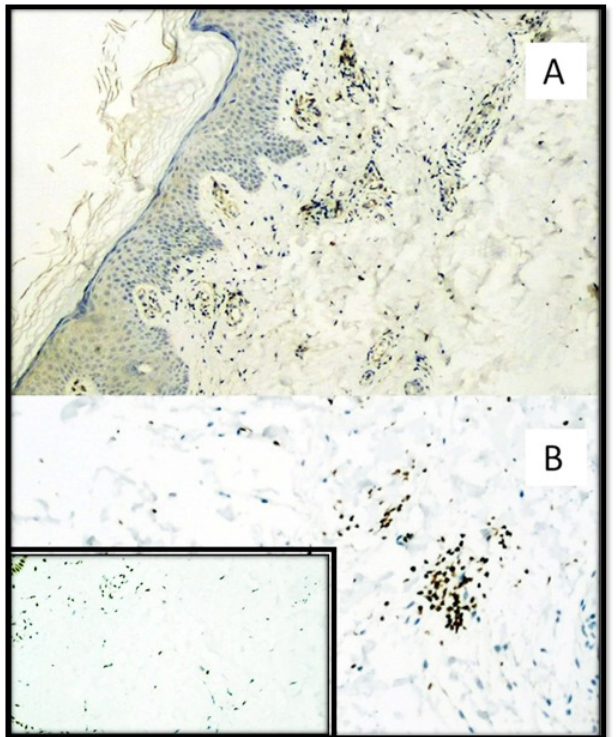
Figure 6. ( A ) TIM-3 immunostaining of SARS-CoV-2 positive patient skin sample by both molecular swab and S1-spike protein immunohistochemistry. Note the presence of predominantly subepithelial T lymphocyte clusters strongly positive for TIM-3. (Immunohistochemistry, Original Magnification: 100 × ). ( B ) Detail of a cluster of TIM-3 positive T lymphocytes (Immunohistochemistry, Original